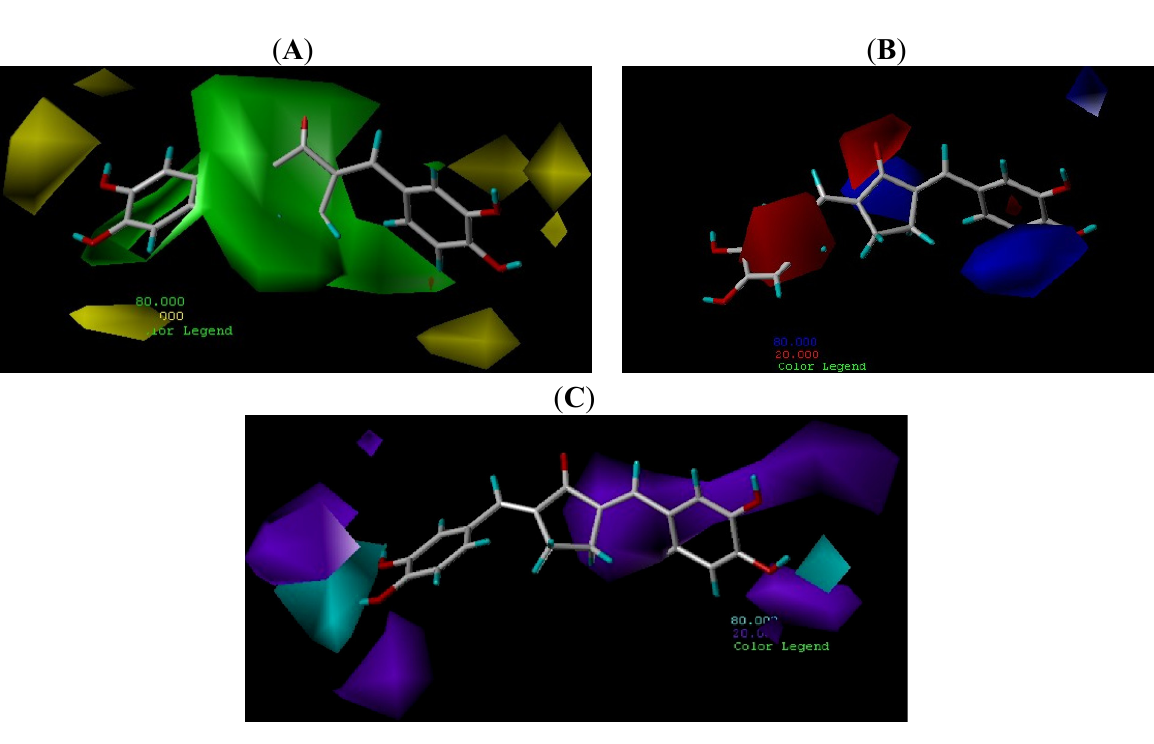
Figure 4. CoMSIA steric filed ( A ) and electrostatic field ( B ); CoMSIA Hydrogen bond donor ( C ). S fields: favored (green) and disfavored (yellow); E fields: Lipophilic (blue) and hydrophobic (red); D field: favored (purple) and disfavored (cyan).